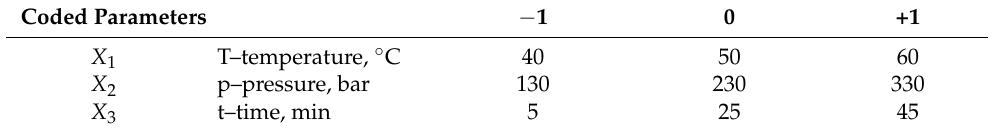
Table 9. Coded and uncoded values of the independent variables applied in the experimental design. Coded Parameters −